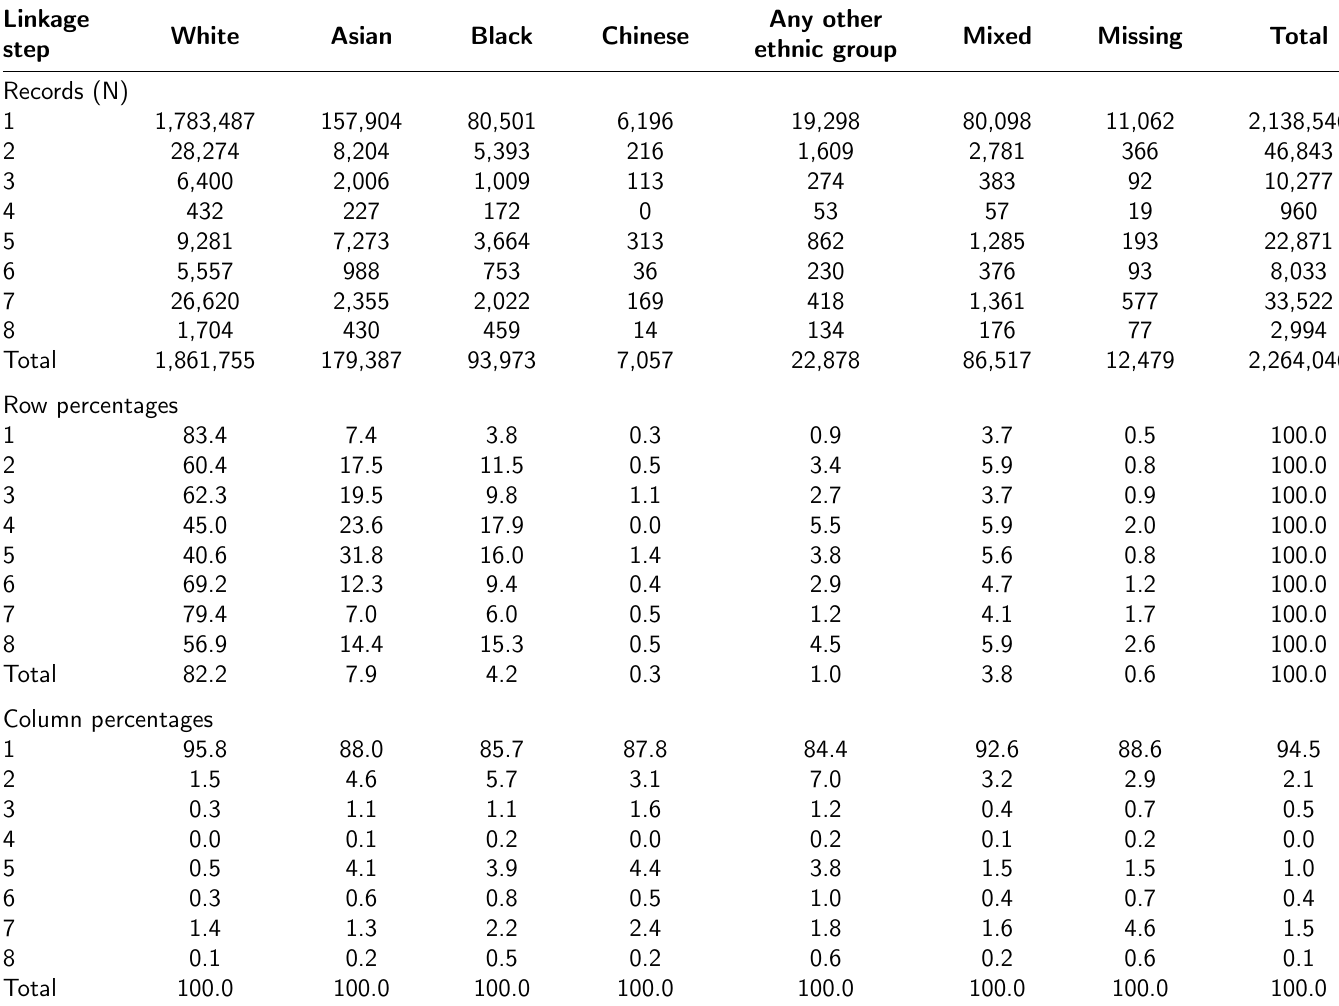
Supplementary Table 6.3: Linkage national pupil dataset to personal demographics service by linkage step and ethnicity (all